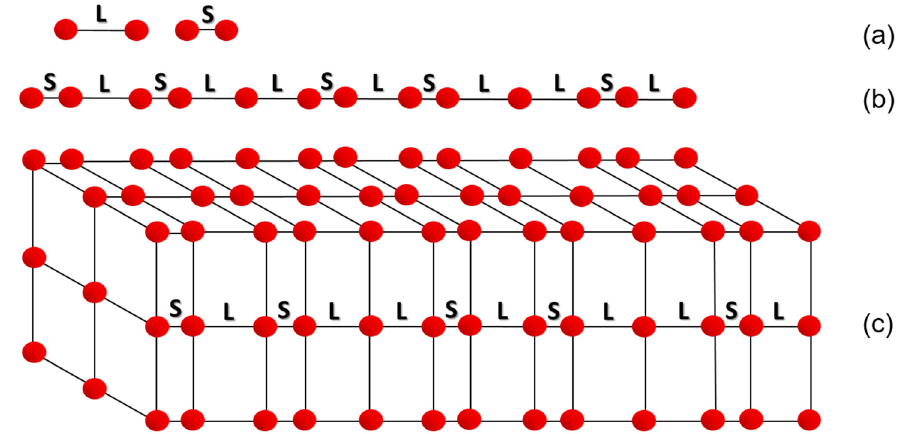
can be obtained. By adding the second and third dimensions, a simple example of a quasi- crystalline lattice can be drawn (Figure 3c).